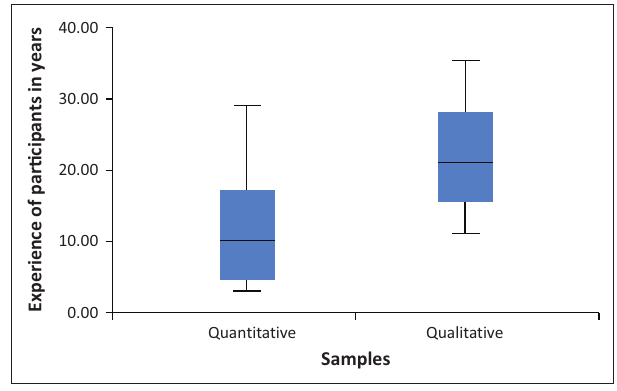
FIGURE 4: Experience in years of the participants in the quantitative and qualitative